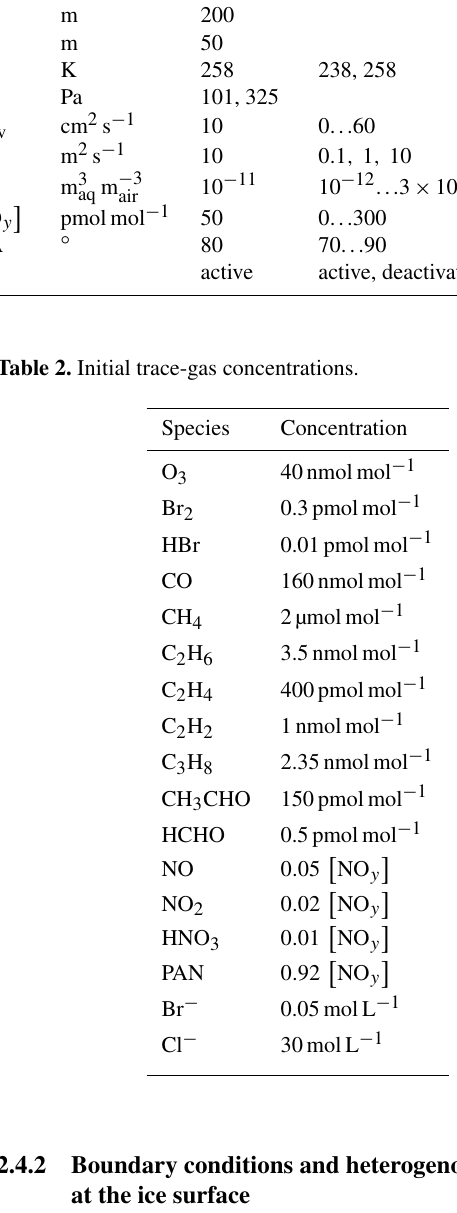
Table 1. Parameter definition for the base-case settings and variations used in the parameter study. Parameter Symbol Unit Base case Values Boundary layer height L Inversion layer thickness L inv Temperature Pressure Turbulent diffusion coefficient in the inversion layer